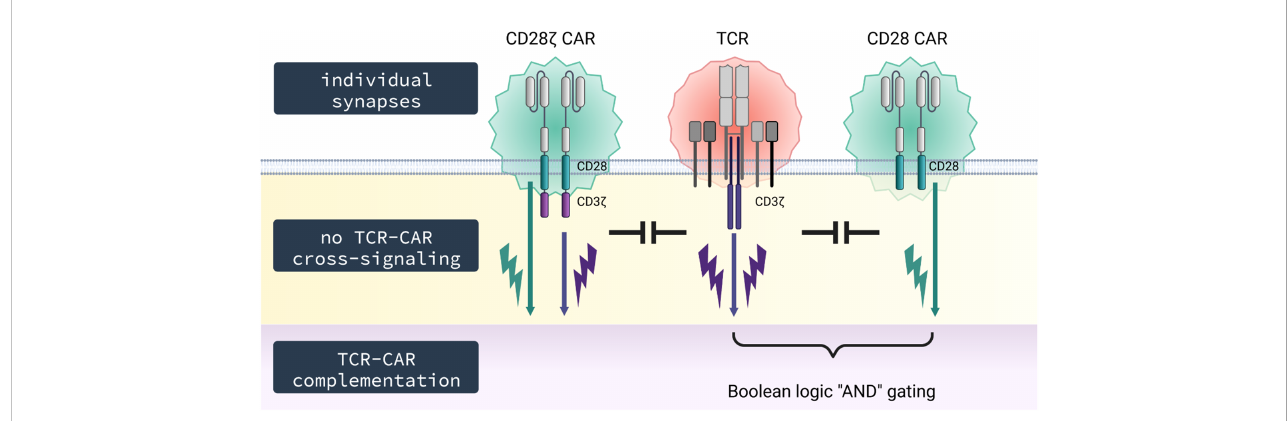
FIGURE 6 Schematic diagram. TCR and CAR do not co-integrate into the same synapse and signal independently upon engagement of their respective antigen without cross-signaling on the membrane level; however, TCR and CAR can complement in signaling upon simultaneous engagement of their respective cognate antigens, thereby providing T cell activation by both CD3 through the TCR and costimulation through the